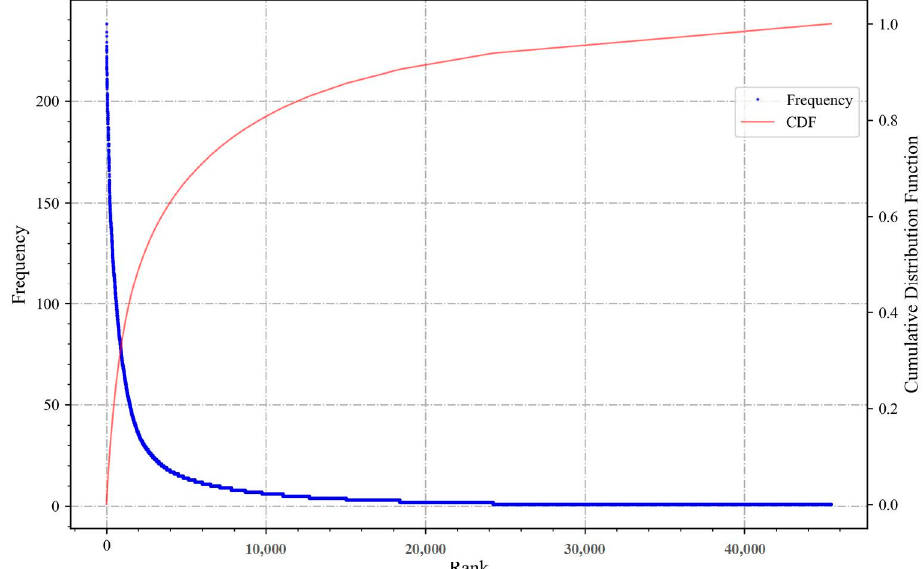
Figure 7. Rank-frequency and CDF of motion words in the trajectory documents.